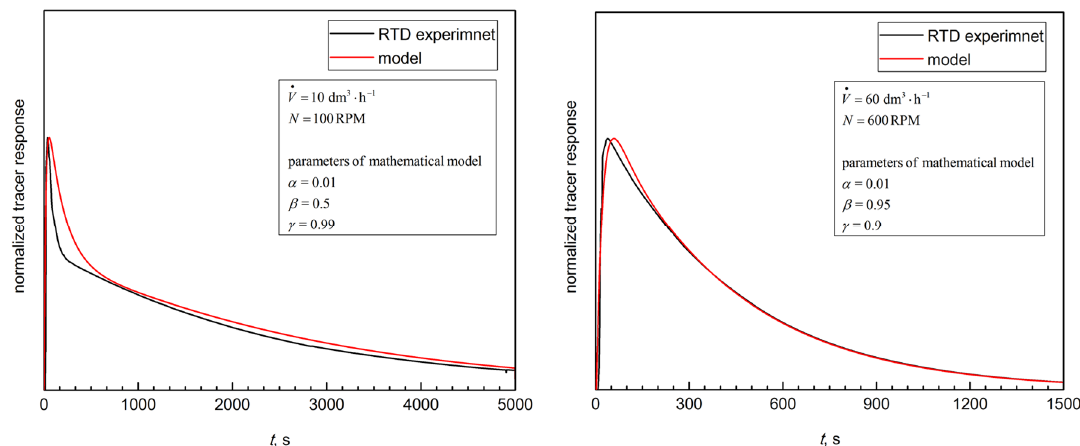
Figure 7. The typical examples of the experimental data fit by using the proposed mathematical model (Equation (2)).